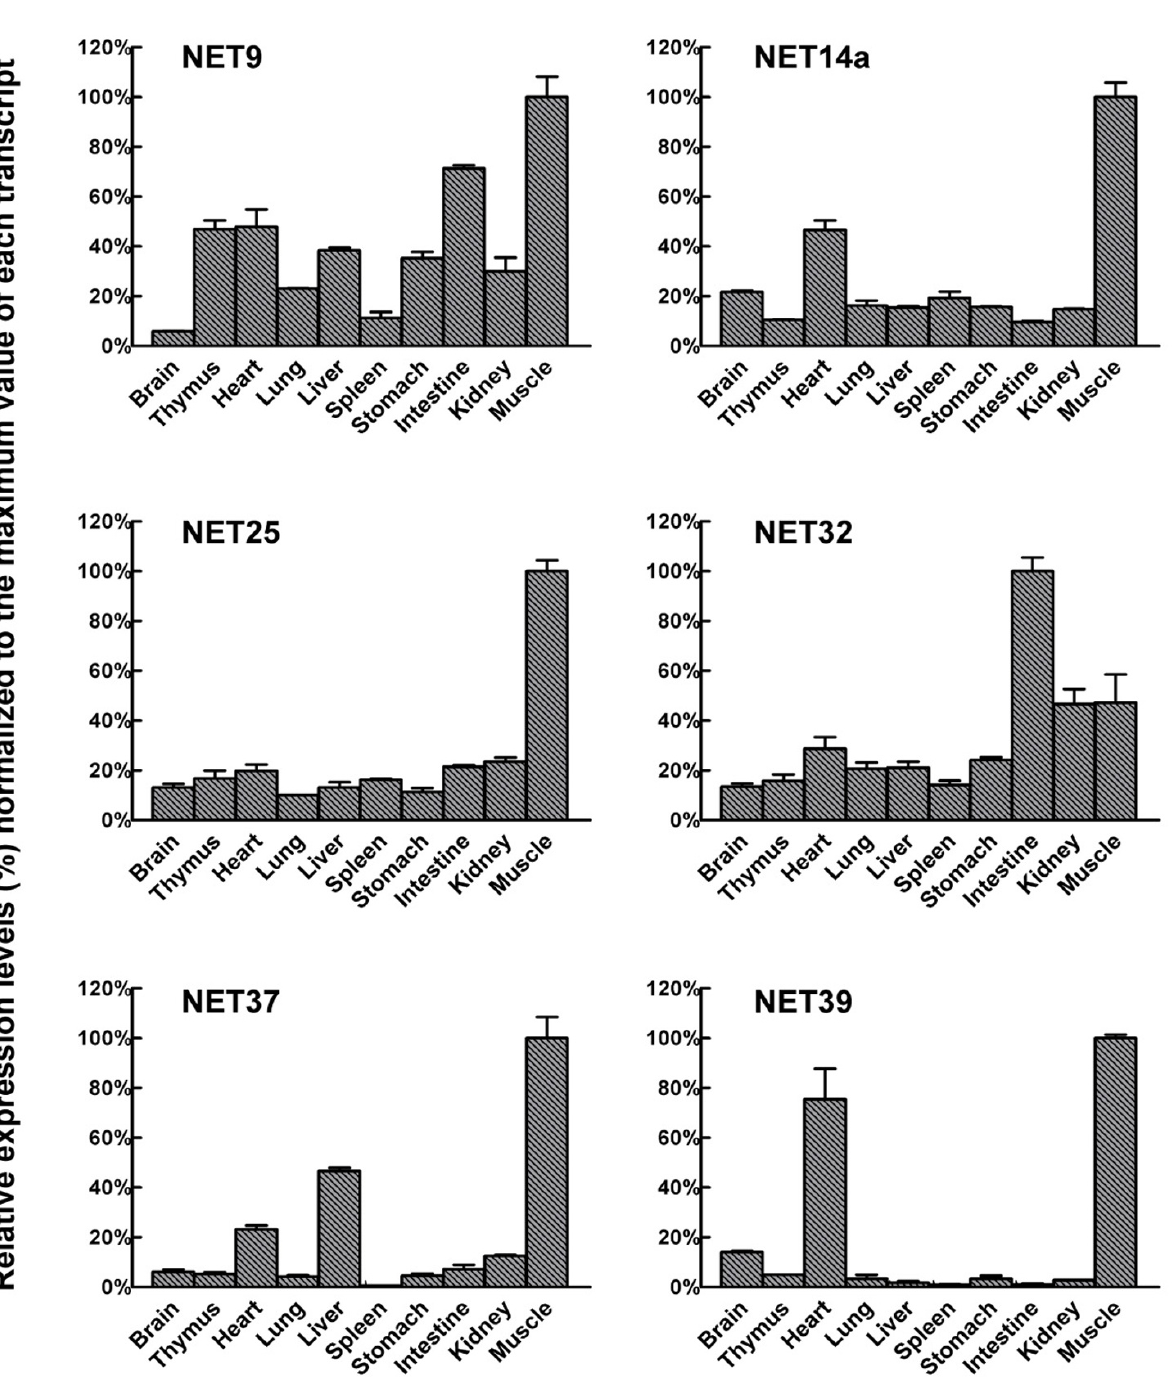
Figure 5 Expression of NETs up-regulated in C2C12 differentiation in 10 tissues of adult mouse . Gene expression levels of the up-regulated NETs during C2C12 differentiation were measured by quantitative/real-time PCR in ten adult C129 mouse tissues. All signal values were normalized to peptidylprolyl isomerase A (Ppia) as in Fig. 4. The left Y-axis indicates the expres- sion level of a gene relative to the highest value (normalized to 100%) in the same tissue. The error bars indicate the standard deviation. The raw data used for preparation of this figure was derived from Additional File